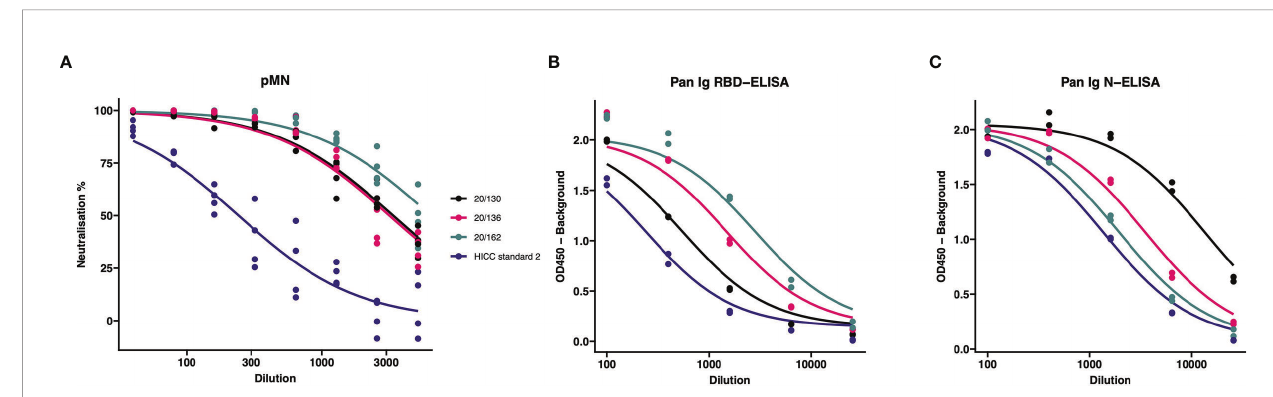
FIGURE 1 | Comparison of internal calibrants and International Standard for neutralization and binding assays. The IC 50 from these curves were used to calculate the (A) International units (IU); (B) RBD-speci fi c Binding Antibody Units (BAU); and (C) N-speci fi c Binding Antibody Units (BAU). Calibrants were run four times at each dilution for pMN and twice for ELISA